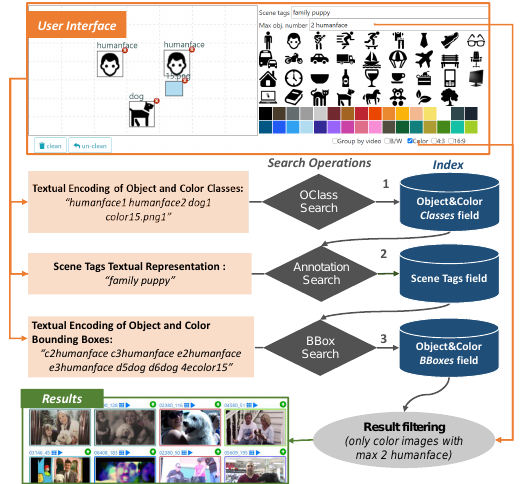
Figure 9. Outline of the search process: the query formulated by the user in the search interface is translated into three textual subqueries. Each subquery is the used by a specific search operation to query our index. The search operations are not performed simultaneously, but in sequence following the order indicated by the numbers in the figure. Search operators in intermediate steps are not performed on the whole dataset but rather on the result set of the search operation performed in the previous